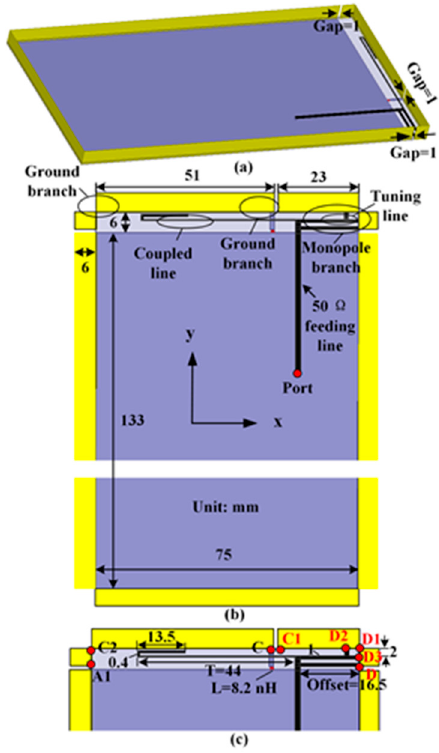
Figure 1. The structure and dimensions of the proposed antenna in millimeters. ( a ) Prospective view. ( b ) Unfolded structure of the antenna. ( c ) Detailed dimensions of some